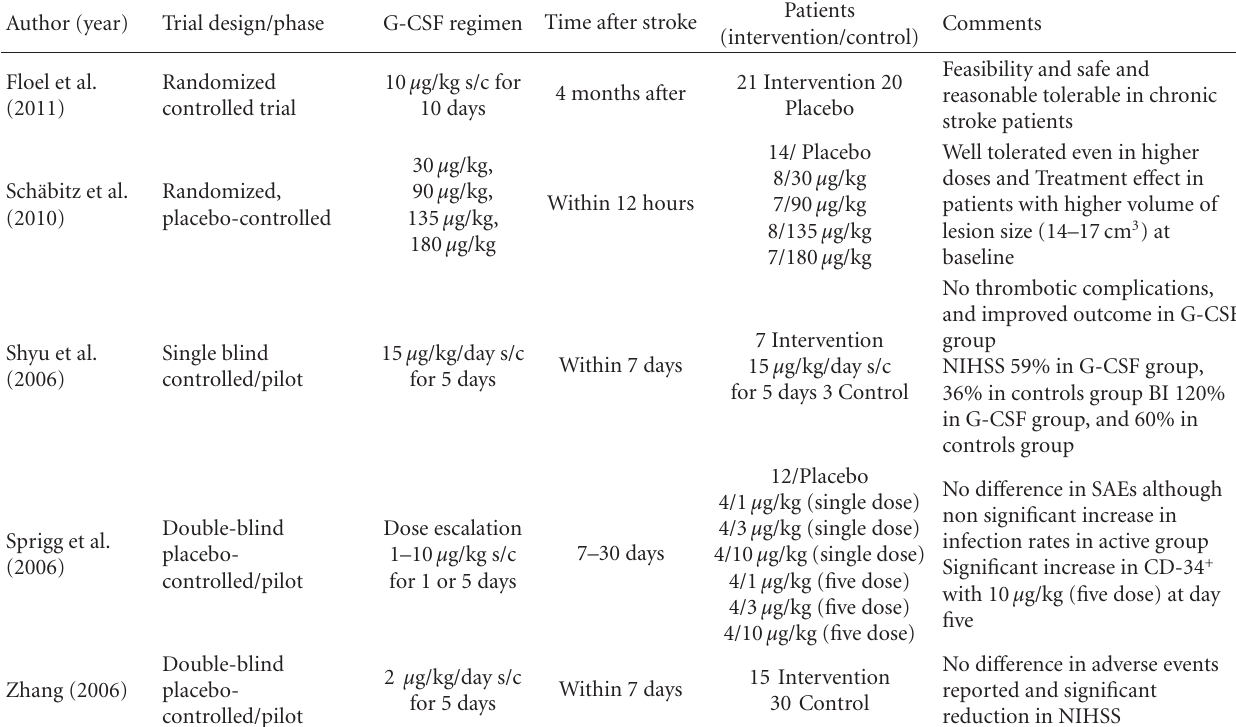
Table 1: Summary of published studies of G-CSF therapy in stroke patients.